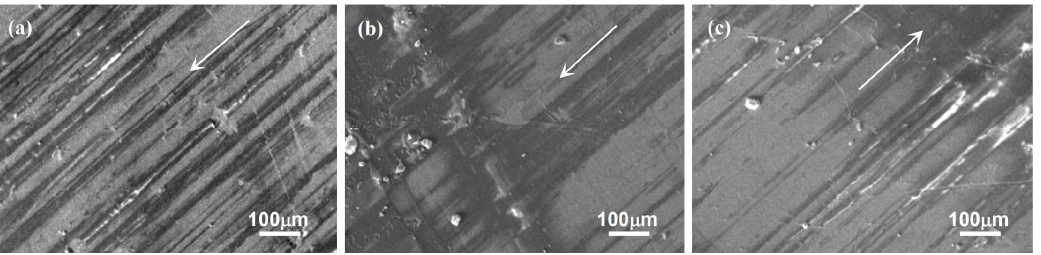
Figure 4. SEM images of the transfer layers under different speeds: ( a ) 0.1 m·s − 1 ; ( b ) 0.4 m·s − 1 ; ( c ) 0.8 m·s − 1 .